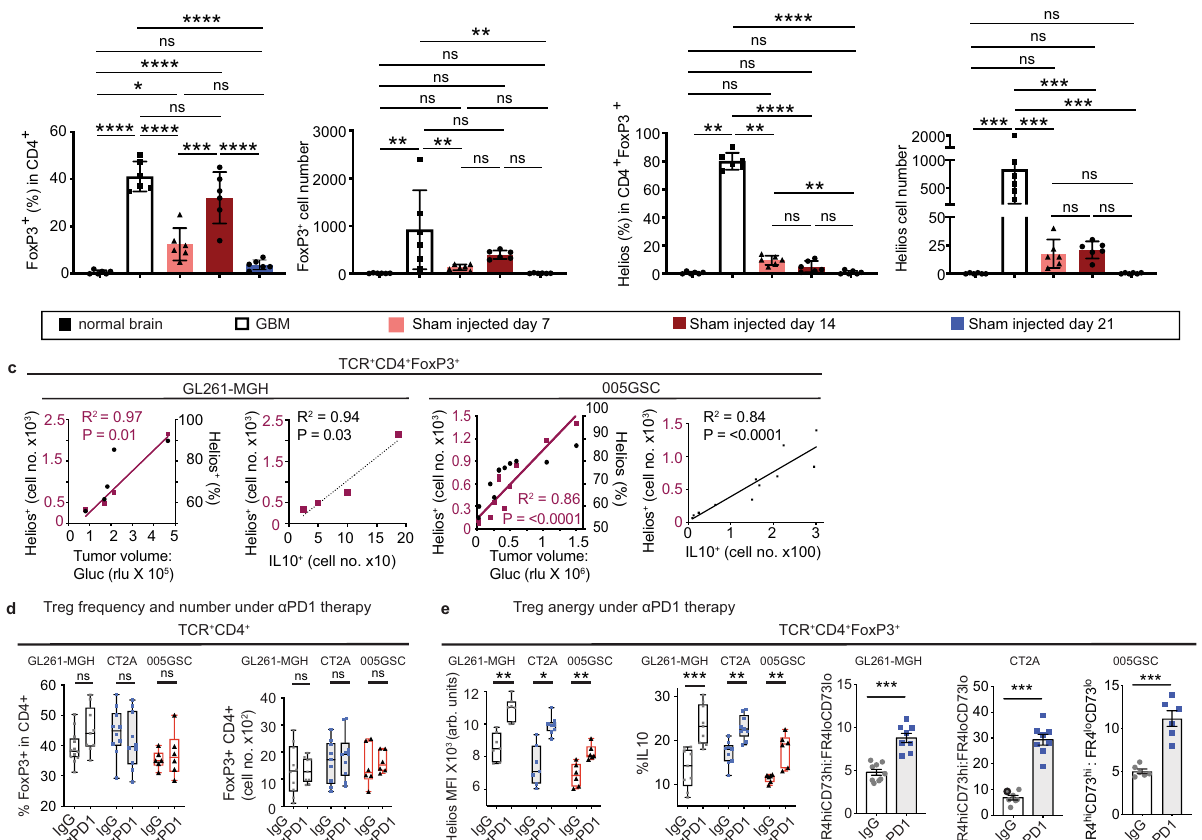
Fig. 1 α PD1 monotherapy does not prolong GBM survival but increases Treg cell anergy in GBM tumors. a Schematic representation of experimental setup to evaluate the effect of IgG2a (isotype control) or α PD1 therapy on the survival of GL261-MGH ( n = 12), CT2A ( n = 12), and 005GSC ( n = 13) GBM- bearing mice (two independent repeats of survival assessment). Median survival for GL261-MGH [IgG2a (15 days), α PD1 (15 days), p = 0.760], CT2A [IgG2a (16 days), α PD1(19 days), p = 0.1730], 005GSC [IgG2a (13 days), α PD1 (13 days), p = 0.3479]. b Treg cells ’ frequency (% of FoxP3 + cells in CD4 T cells) (left) and number (second panel) in the normal brain compared to tumor tissue (GL261-MGH), and PBS injection at days 7, 14 and 21 post injection. Correlation of Helios + GBM Treg cells (cell number (third panel from right) and frequency (right panel) in the normal brain, GL261-MGH tumors, and sham injected brain at days 7,14 and 21 quanti fi ed by FACS ( n = 6 biological replicate). Data presented are mean ± SEM. P < 0.0001 by ordinary one- way ANOVA test and were corrected for multiple comparisons using the Tukey adjustment. For between group analysis post-Tukey, Statistical signi fi cance is shown as * p < 0.05, ** p < 0.01, *** p < 0.001, **** p < 0.0001. c Correlation of Helios + GBM Treg cells (cell number and frequency) with tumor volume (purple left Y -axis; black right Y -axis, respectively) (left for both GL261-MGH and 005GSC) and correlation of Helios expressing Treg cells with IL10 expressing Treg cells (right for both GL261-MGH and 005GSC) cell numbers in GBM) (GL261-MGH n = 5, 005GSC n = 11), using linear regression analysis. d Treg cell frequency(left) [GL261-MGH (IgG n = 12, α PD1 n = 9); CT2A (IgG n = 10, α PD1 n = 10); 005GSC (IgG n = 6, α PD1 n = 6)]. and cell numbers (right) [GL261-MGH (IgG n = 10, α PD1 n = 10); CT2A (IgG n = 10, α PD1 n = 10); 005GSC (IgG n = 6, α PD1 n = 6)], quanti fi ed by FACS.